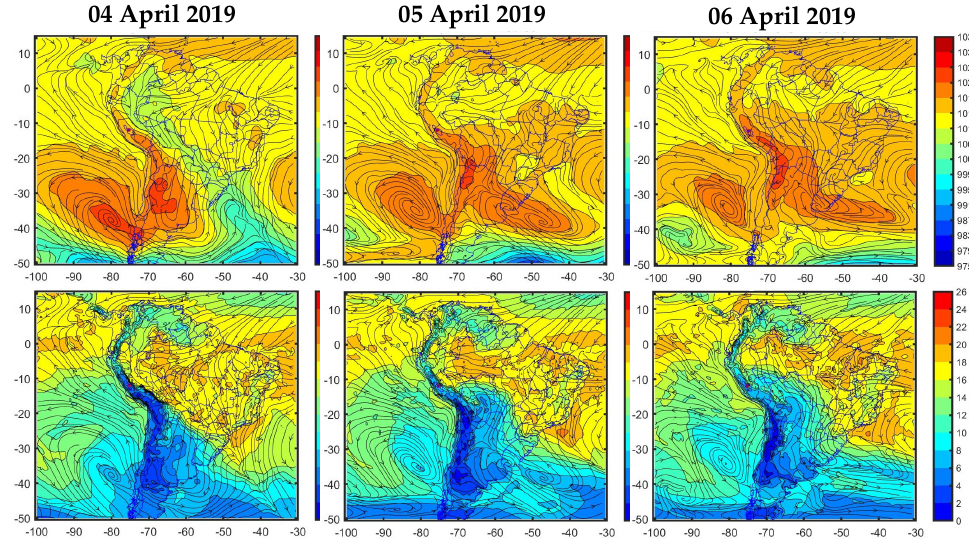
Figure 14. Contours of pressure reduced to sea level (hPa) and contours of specific humidity (g kg − 1 ) for South America ( first column ) on 4 April 2019 at 12 UTC (07 LT), ( second column ) on 5 April 2019 at 12 UTC (07 LT) and ( third column ) 6 April 2019 at 12 UTC (07 LT). Geopolitical contours are